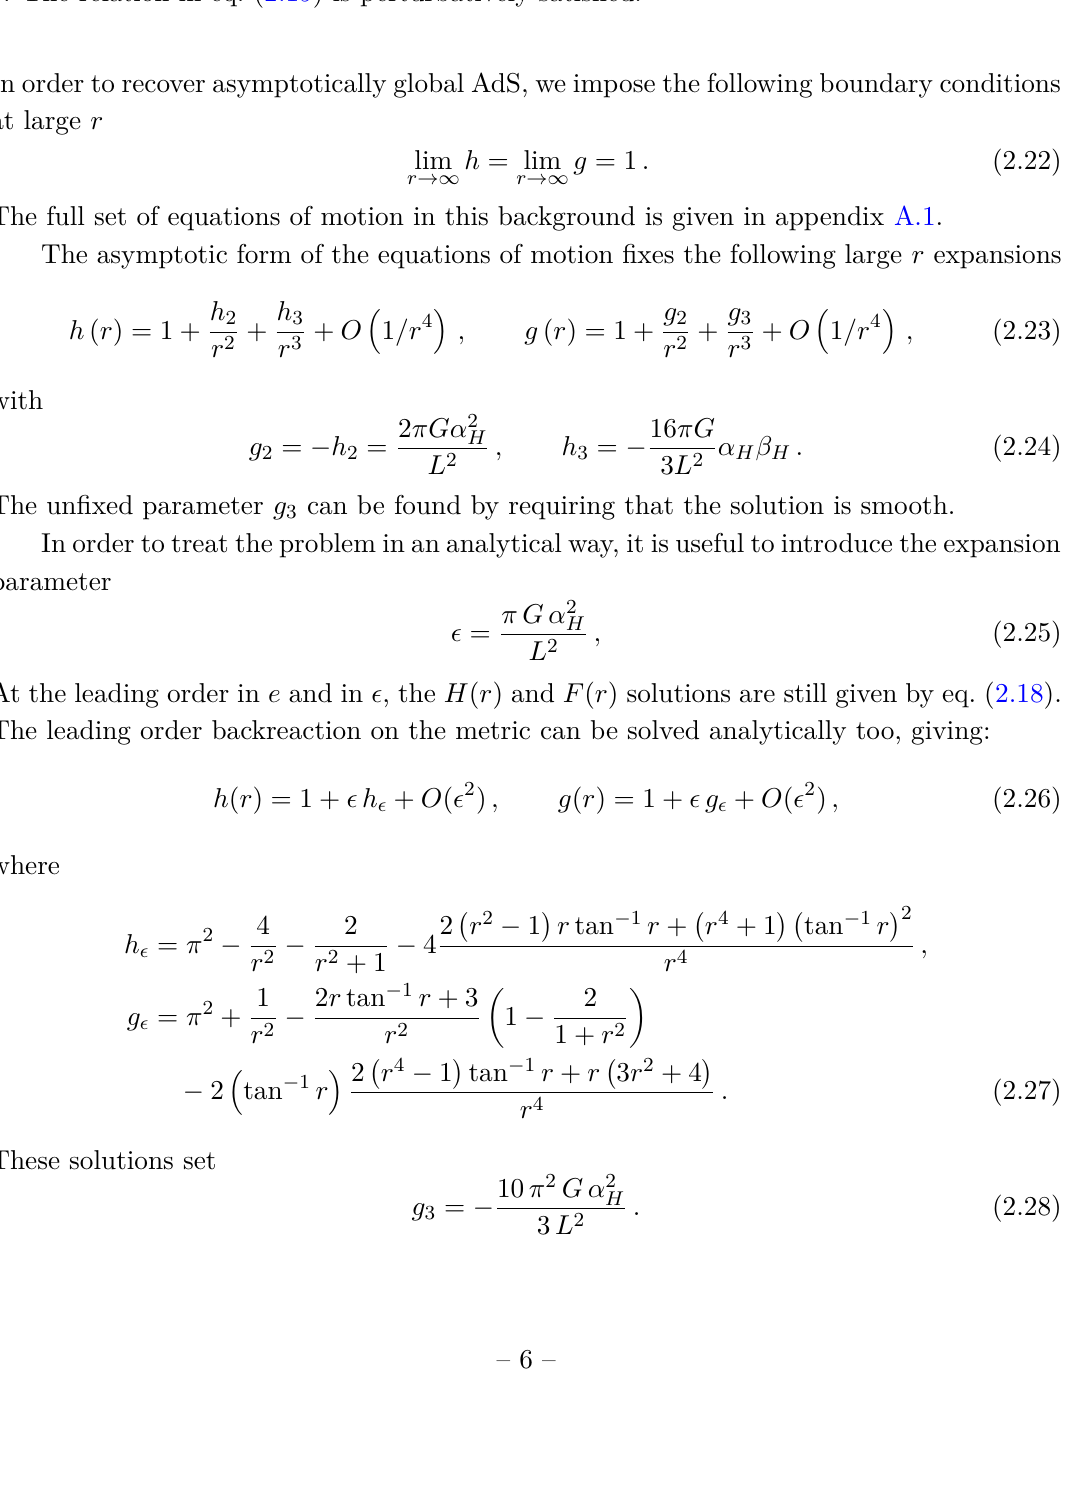
Figure 2 : Plot of the relation between the coefficients α e . The relation in eq. (2.19) is perturbatively